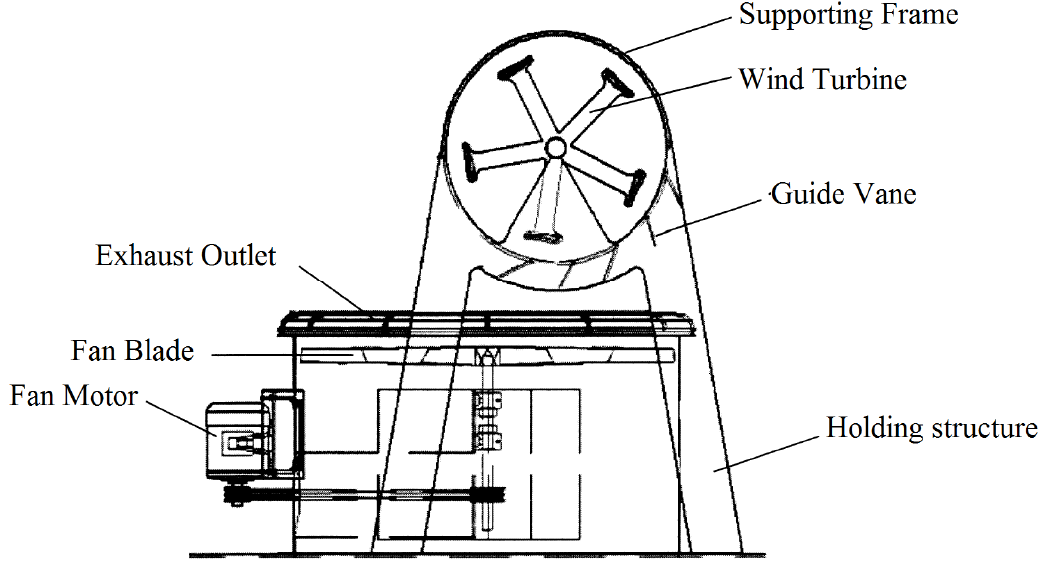
Figure 1. General arrangement of the exhaust air energy recovery turbine generator, reprinted with permission from [16]. Copyright 2011